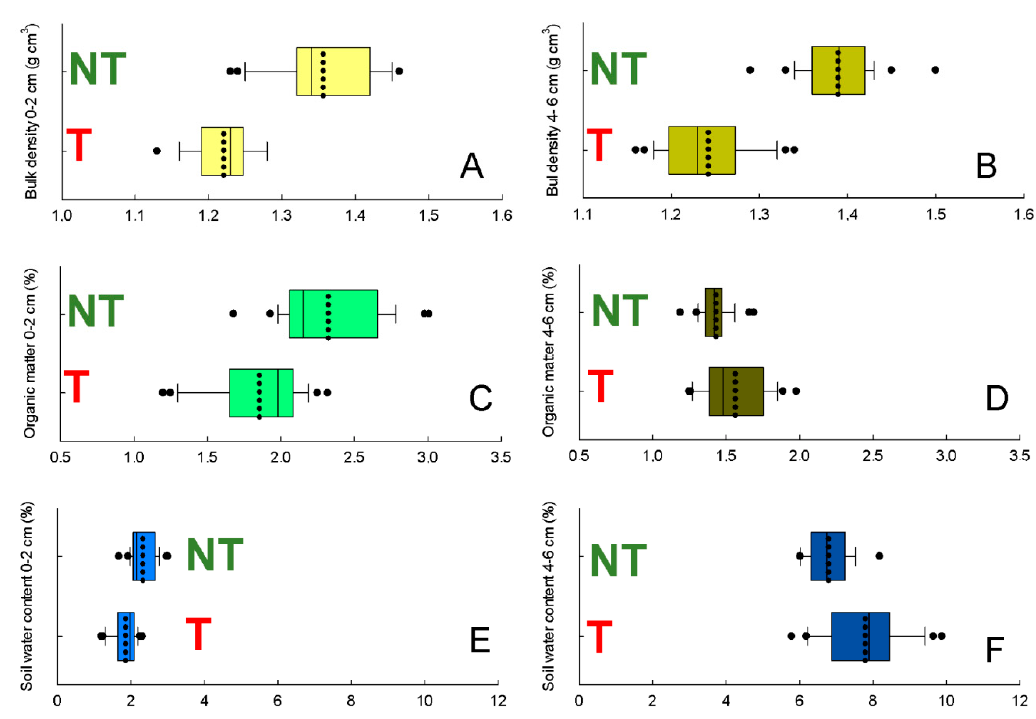
Figure 6. Soil properties at 0–2 (left side) and 4–6 (right side) cm. ( A , B ): bulk density (g cm − 3 ); ( C , D ): organic matter (%); ( E , F ): soil moisture (%) for the 25 plots under Tillage (T) and 25 plots under No-Tillage (NT). Black dotted line: mean values; black thin line: median; points: outliers.